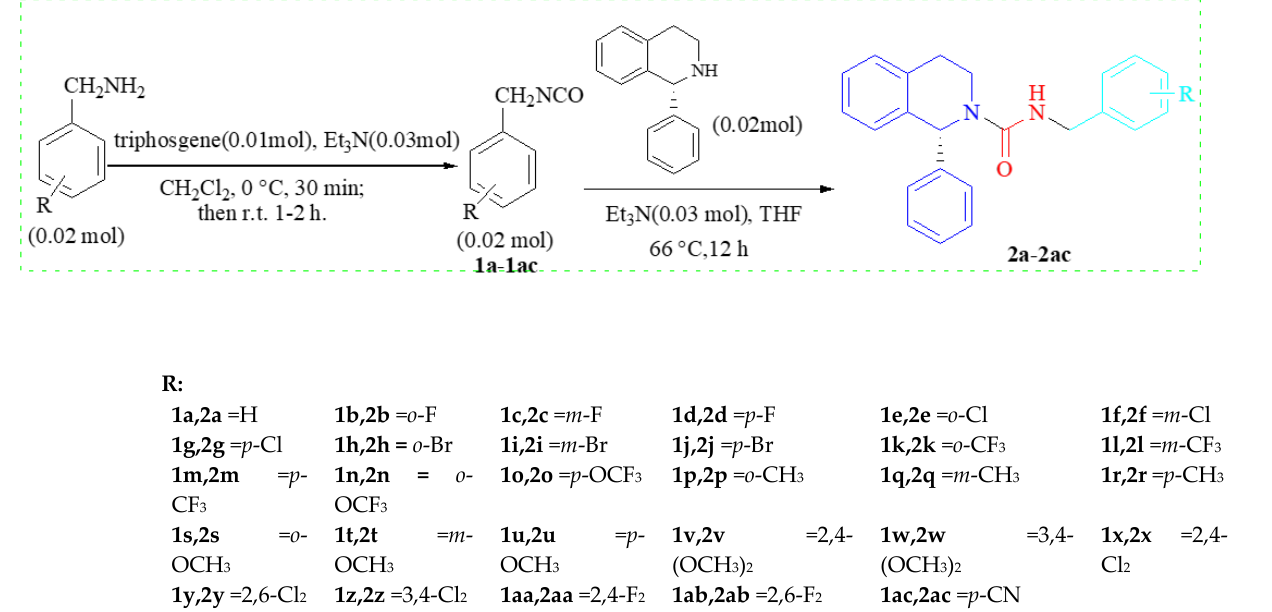
Scheme 1. Synthetic route of derivatives 2a – 2ac